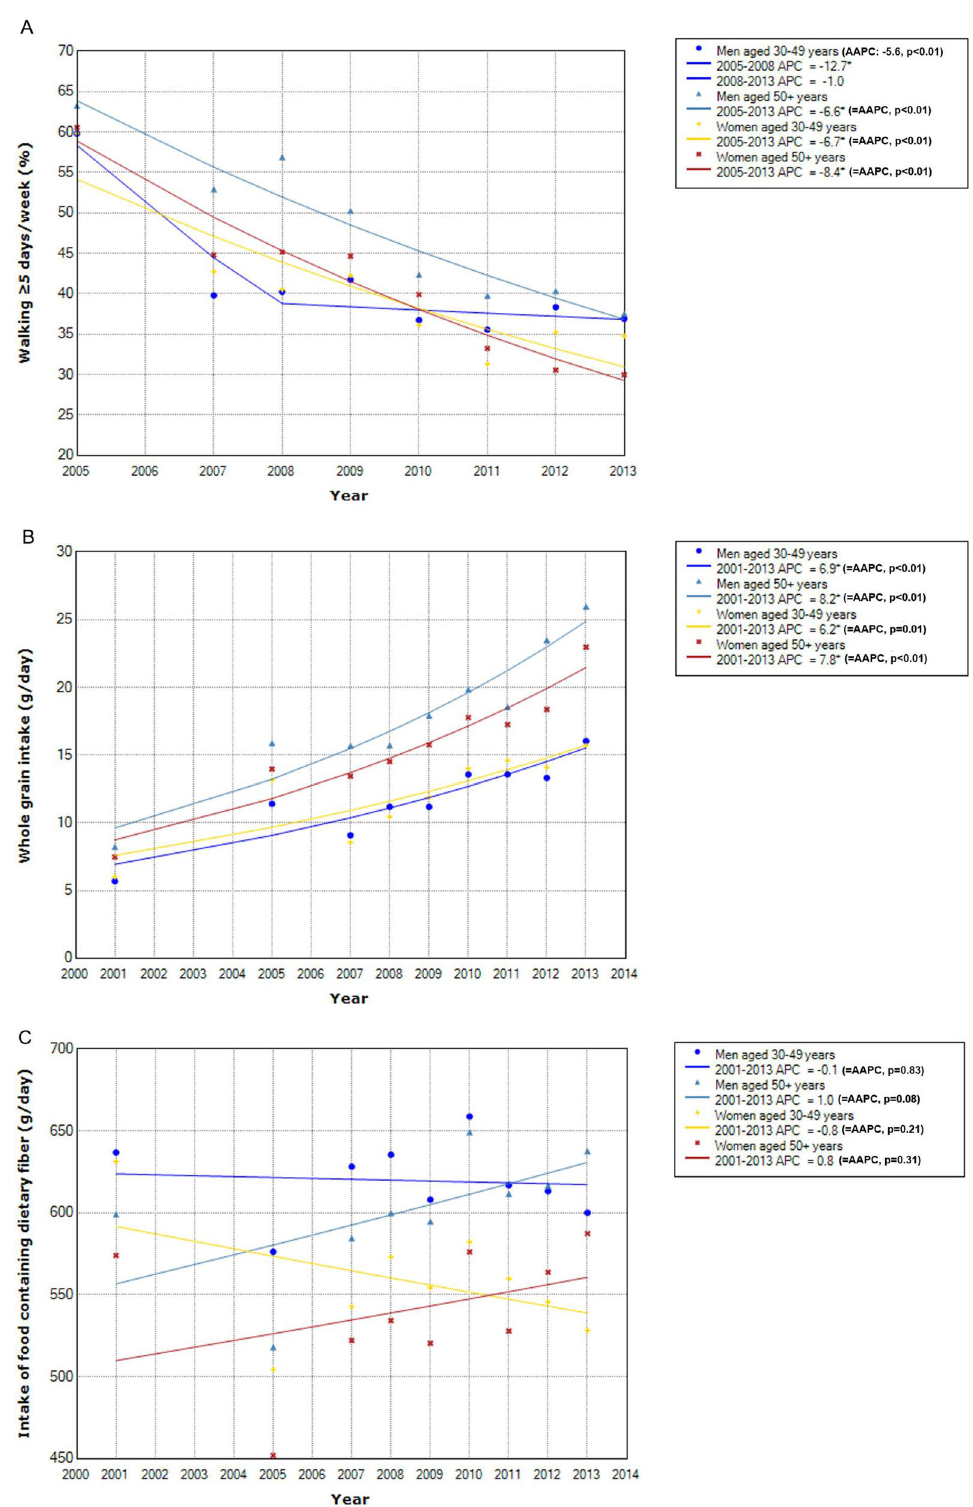
Figure 4. Time trend of distribution of protective factors by sex and age. * Indicates that APC is significantly different from zero at the alpha = 0.05 level. ( A ) Physical activity (walking at least 5 days per week). ( B ) Whole grain intake. ( C ) Intake of food containing dietary fiber. ( D ) Dairy intake. ( E ) Calcium supplement